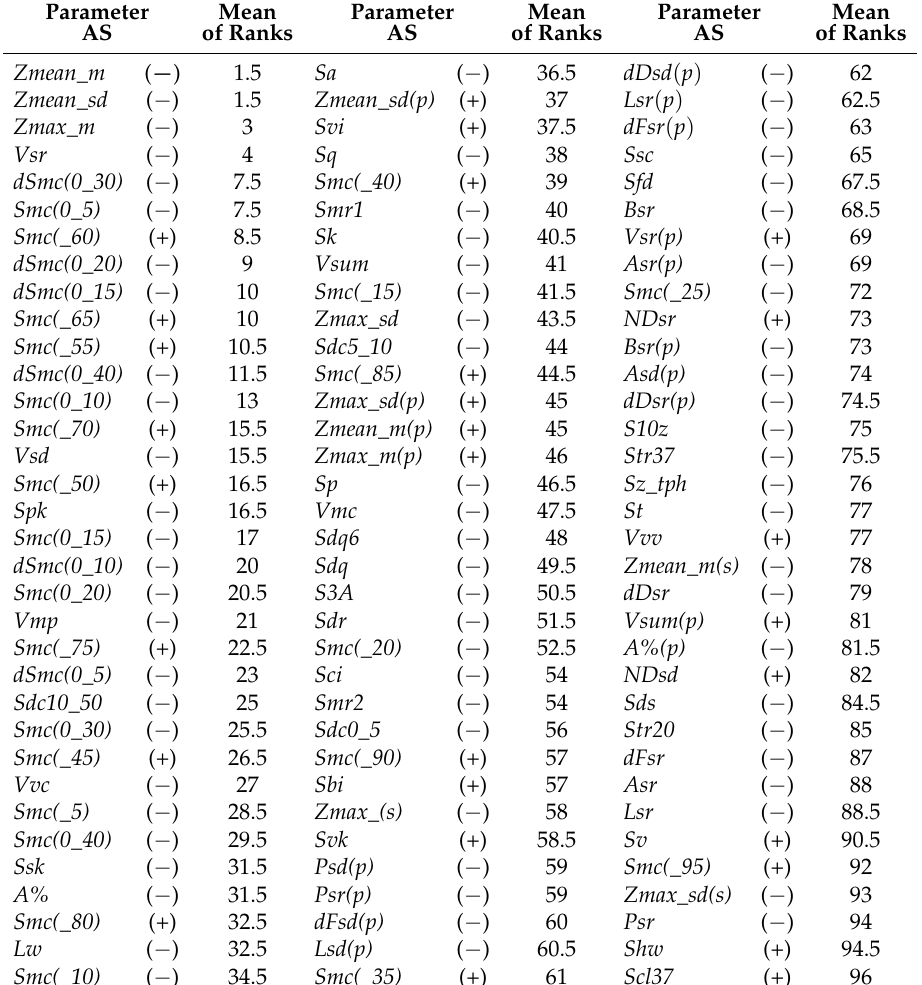
Table 3. Mean values of ranks assigned to surface texture parameters, islands and pores for which the null hypothesis H 0 was rejected. The sign ( − ) next to the parameter name means that its value decreased with the wear of the grinding wheel. The sign (+) indicates the opposite